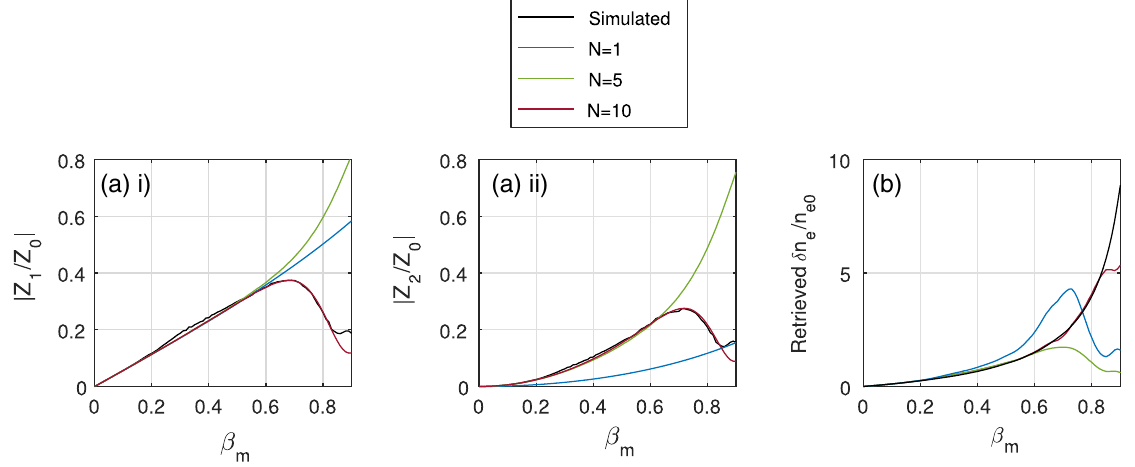
FIG. 4. (a) The calculated ratios j Z κ =Z 0 j against plasma wave amplitude β for (i) the κ ¼ 1 and (ii) κ ¼ 2 satellite peaks. The ratios m are approximated using N ¼ 1 (blue), N ¼ 5 (green) and N ¼ 10 (red) and are compared to simulations of the ideal ratios (black). (b) The wakefield amplitude retrieved using the peak ratios j Z κ =Z 0 j against the simulated plasma wave